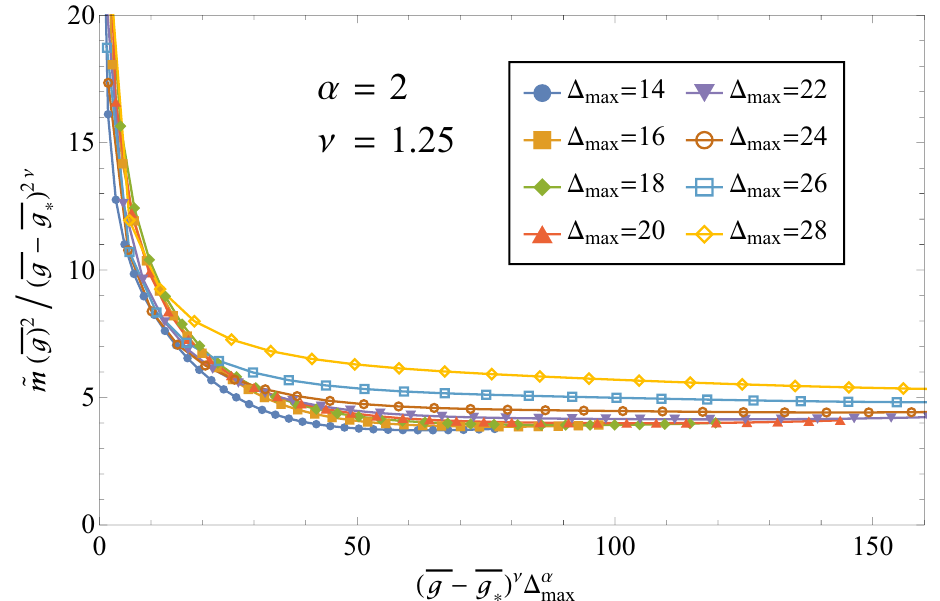
Figure 9 . Testing the scaling collapse ansatz of the IR truncation effects. The hypothesis is that the mass gap data at different truncation level ∆ max are related by (4.17) and (4.18) above and below the proposed IR scale (4.16), respectively. Taking the theoretical value of the critical exponent ν = 1 . 25 we find from observation that the best parameter that relates different ∆ max is near α ≈ 2. First, above the IR scale (large x -axis), the ratio ( y -axis) between the mass gap and the power law becomes constant (4.17) for all ∆ max , indicating that the mass gap is well-fitted by a power law with the correct critical exponent. Second, below the IR scale (small x -axis) the curves for all ∆ max merge to the same behavior, indicating the truncation effect attracts the mass gap to a universal behavior modeled by (4.18) with the parameter α ≈